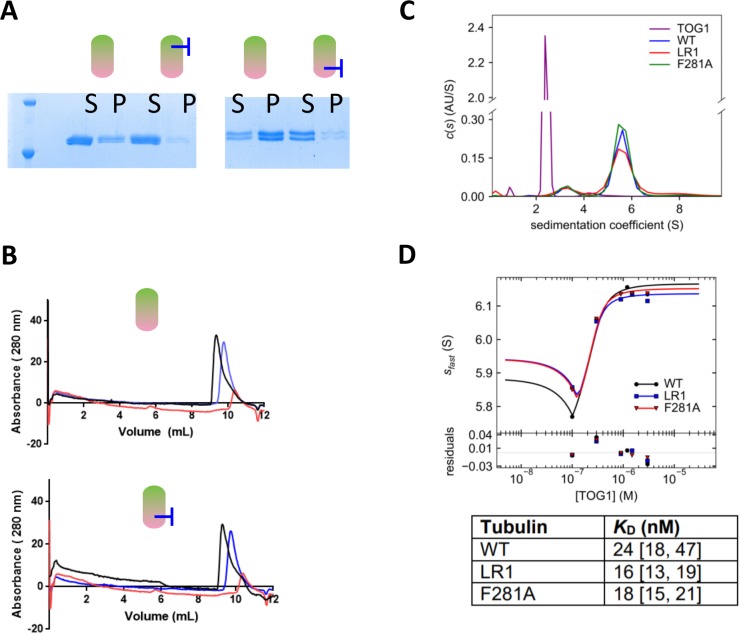
Assays characterizing the assembly and TOG-binding properties of tubulin with a mutated lateral interface.(A) ‘Spin-down’ assays for microtubule assembly reveal by SDS-PAGE that mutations on the lateral interface of β-tubulin (left, F281A) or α-tubulin (right, H284A) reduce the extent of microtubule assembly compared to wild-type. S = supernatant, p=pellet. Assays were performed using 1 μM tubulin. (B) A gel filtration binding assay demonstrate that a lateral tubulin mutant, Tub1-H284A, binds a TOG domain comparably to wild-type tubulin. Left: Overlaid gel filtration traces of WT tubulin alone (blue), TOG1 alone (red), and the tubulin + TOG mix (black). The shift to earlier elution volumes indicates formation of a larger complex. Right: Overlaid gel filtration traces of α-H284A tubulin alone (blue), TOG1 alone (red, repeated from left panel), and the tubulin + TOG mix (black). A similar shift in elution indicating the presence of a TOG:tubulin complex was observed. All samples contain 1 μM tubulin variant and 1 µM TOG1. (C) Analysis of TOG1:αβ-tubulin interactions by sedimentation velocity. The plot shows c(s) distributions (color coded by sample) for each control sample: TOG1 alone (2 µM, purple), WT tubulin (0.3 µM, blue), ‘LR1’ plus-end blocked tubulin (β-tubulin: T175R, V179R) (0.3 µM, red) and ‘F281A’ (β-tubulin: F281A) (0.3 µM, green). (D) Isotherms for Stu2 TOG1 domain binding to WT tubulin (black), plus-end blocked tubulin ‘LR1’ (β-tubulin:T175R,V179R) (blue) and side-block tubulin ‘F281A’ (β-tubulin:F281A) (red). TOG1 binds with comparable affinity to all three tubulin variants including the two tubulin mutants (plus-end and side-block) and WT tubulin. Fitted binding affinities and 1 σ confidence intervals for fitted affinities (in parentheses) are shown in the table on the right.